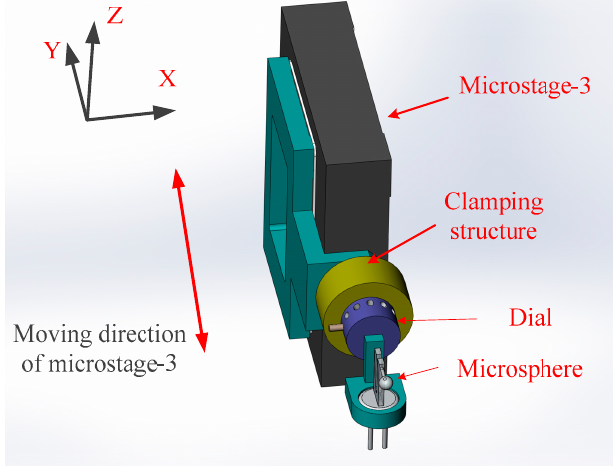
Figure 7. The clamping fixture of the microsphere.